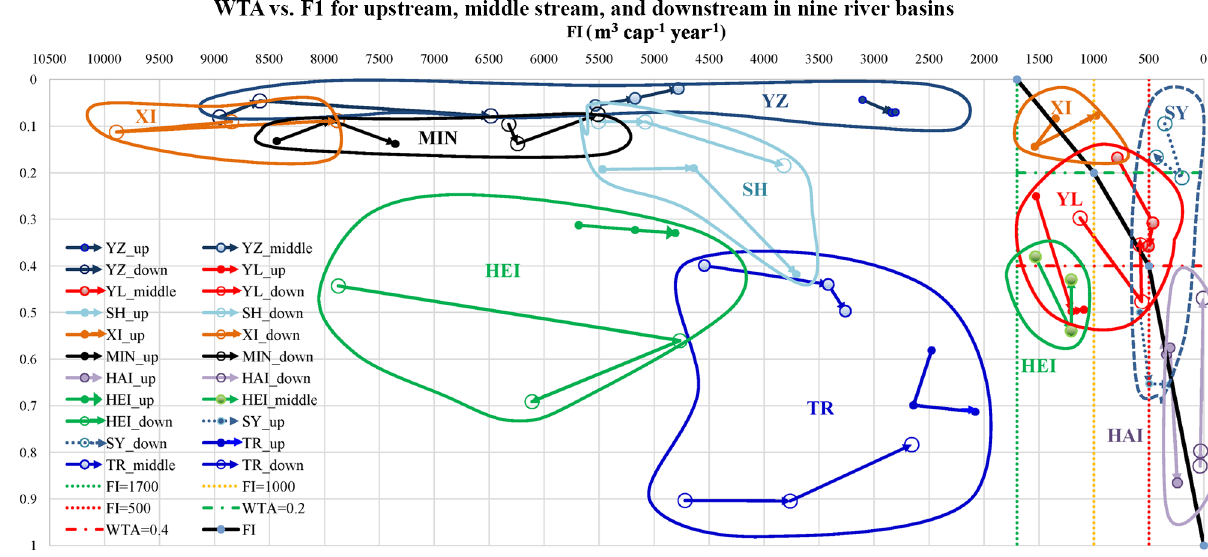
Figure 7. The combined analysis of WTA and FI showing the water scarcity trajectories in nine river basins in the period of the 1980s–2000s. YZ represents Yangtze River basin, XI represents Pearl River basin, MIN represents Min River basin, SH represents Songhua River basin, YL represents Yellow River basin, HAI represents Hai River basin, SY represents Shiyang River basin, HEI represents Hei River basin, and TR represents Tarim River